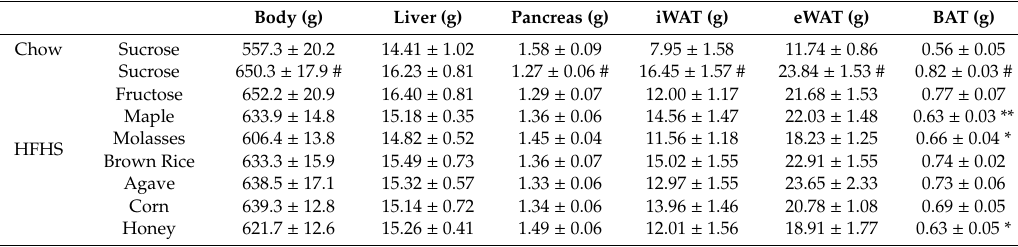
Body and organs weights after 8 weeks of treatment in male Wistar rats. Data represent mean ± SEM, n = 10–12 rats. # p < 0.05, t -test for chow-sucrose (reference for high fat high sucrose (HFHS)-induced obesity) versus HFHS-sucrose. * p < 0.05, ** p < 0.01, one-way ANOVA for fructose and natural sweeteners versus HFHS-sucrose. BAT, brown adipose tissue; eWAT, epididymal white adipose tissue; iWAT, inguinal white adipose tissue.